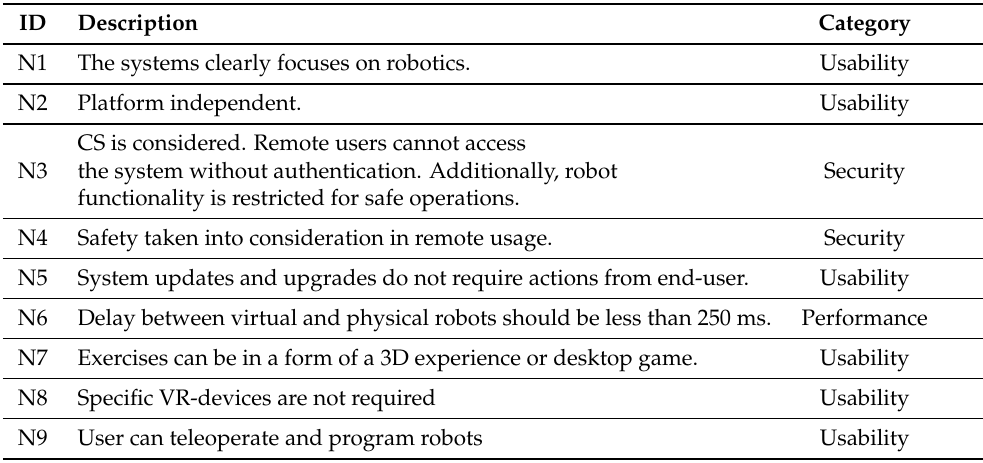
Figure 1. Methodology used in this work to develop and validate virtual environments. The foundation for planning is based on published results in the field and close collaboration with the industry. In the planning phase, requirements for the system are defined. Based on the specification, the system architecture is developed and validated. During the iterative implementation, the system is built and validated for the final evaluation. Table 1. Requirements specified for virtual